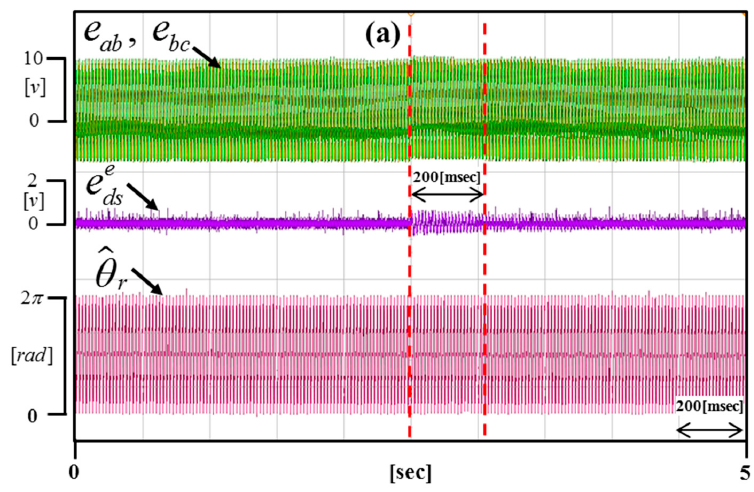
Figure 16. Experimental results according to changing the DC offset error (Operating condition: ω = 3000 r/min). r